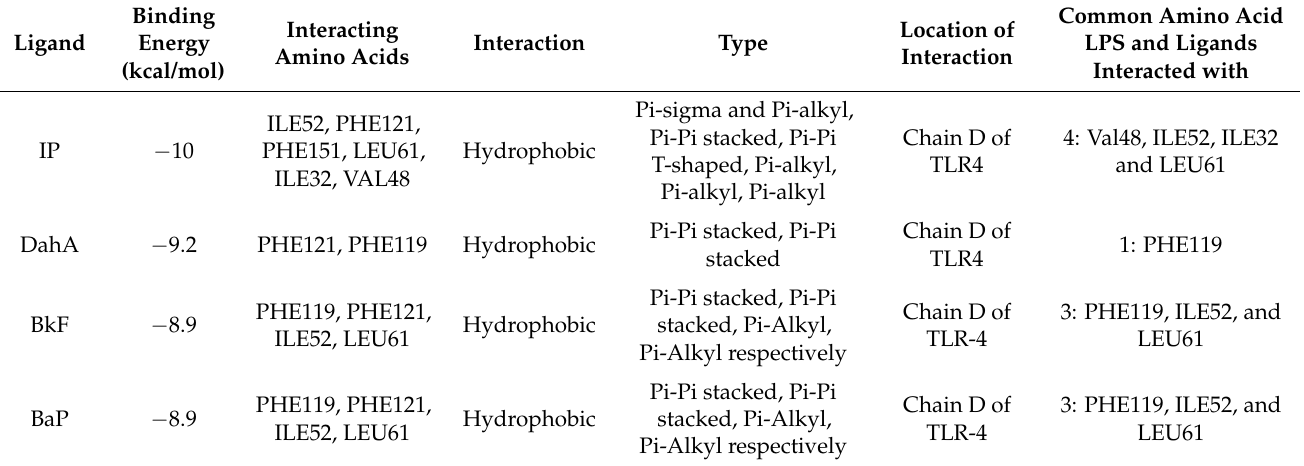
Table 2. Interactions between the highest binding affinity ligands with the human Toll-like receptor 4